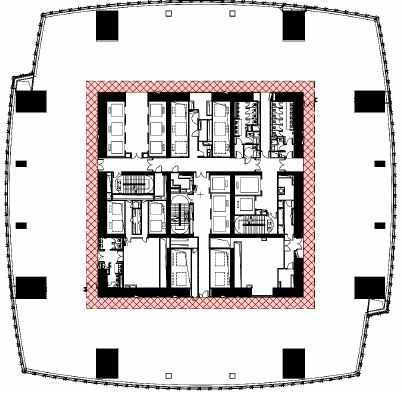
Figure 4. Legend of Traffic Space Area.